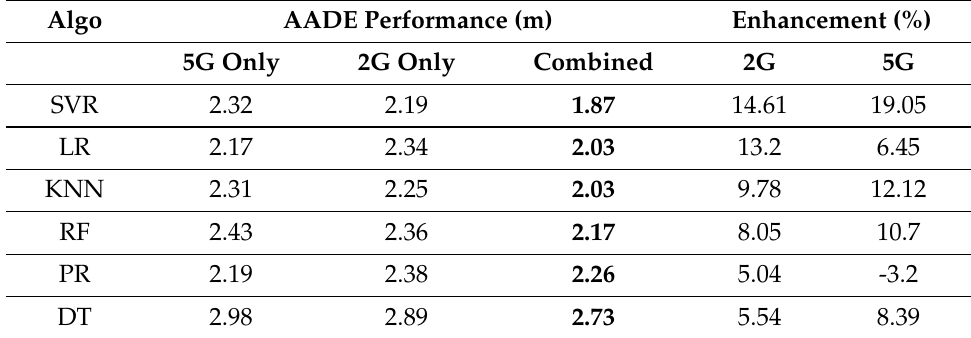
Table 4. AADE performance and performance enhancement in